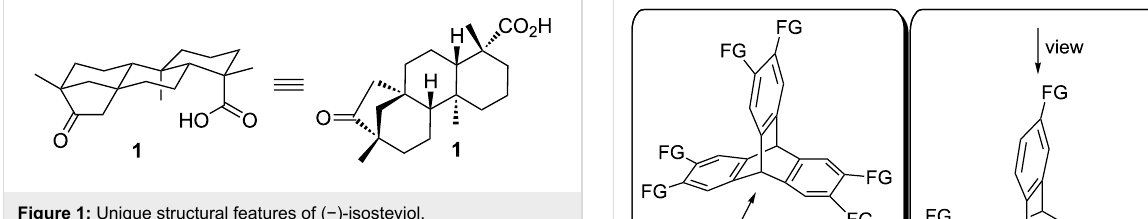
rebaudiana by alcoholic extraction [29,30]. In addition to their cytotoxic activities [31-34], compounds based on ( − )-isosteviol have found application in various fields of synthetic chemistry [35], including the construction of tweezer-like supramolecular transporters for amino acids [36], chiral organocatalysts in aldol reactions [37], or the complex formation with aromatic com- pounds [38,39], Within in a nine-step synthesis triphenylene ketals based on ( − )-isosteviol were prepared [40]. Receptor structures 2 equipped with amino or sulfonylamido functionali- ties were obtained (Figure 2).